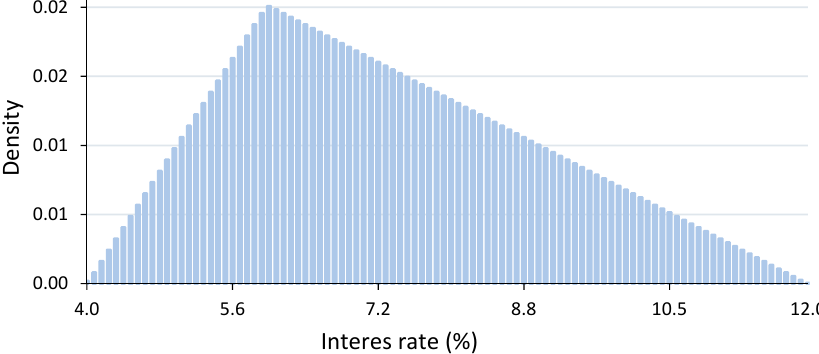
Figure 2. Probability density function (PDF) of the interest rate used in the Monte Carlo method.